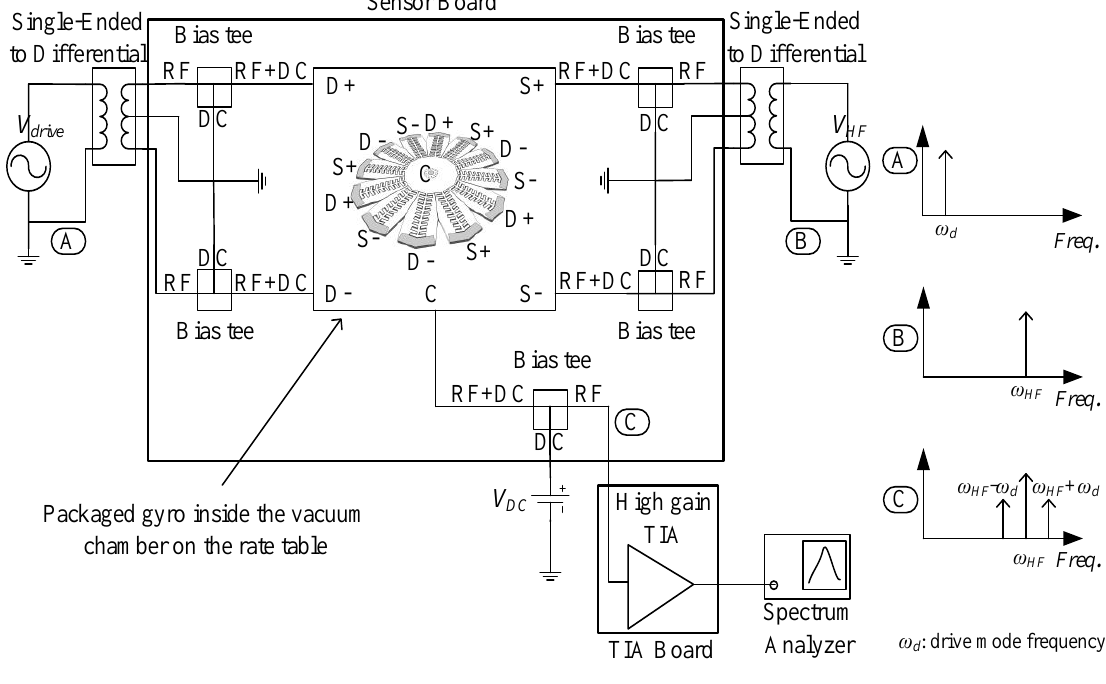
Figure 13. Schematic of the test setup showing the signal frequency spectrum at important nodes. Single-Ended to Differential